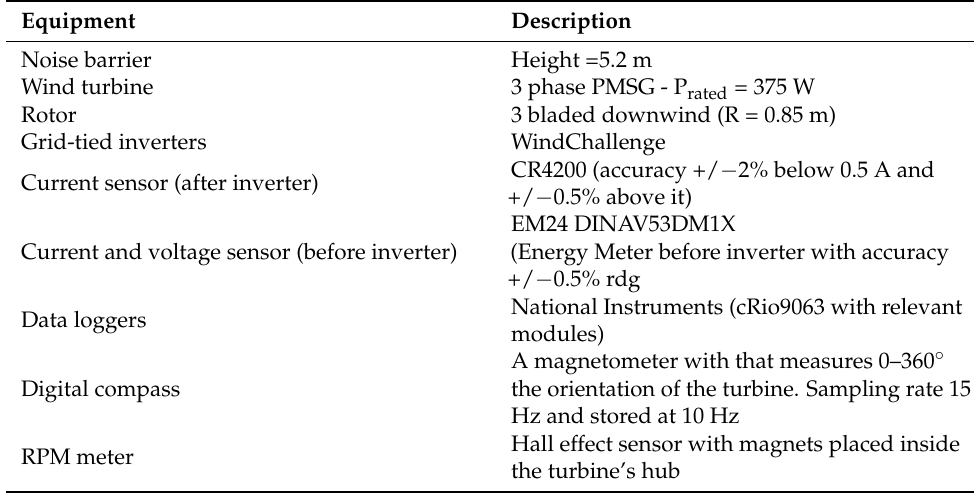
Table 2. Field experimental equipment and relevant